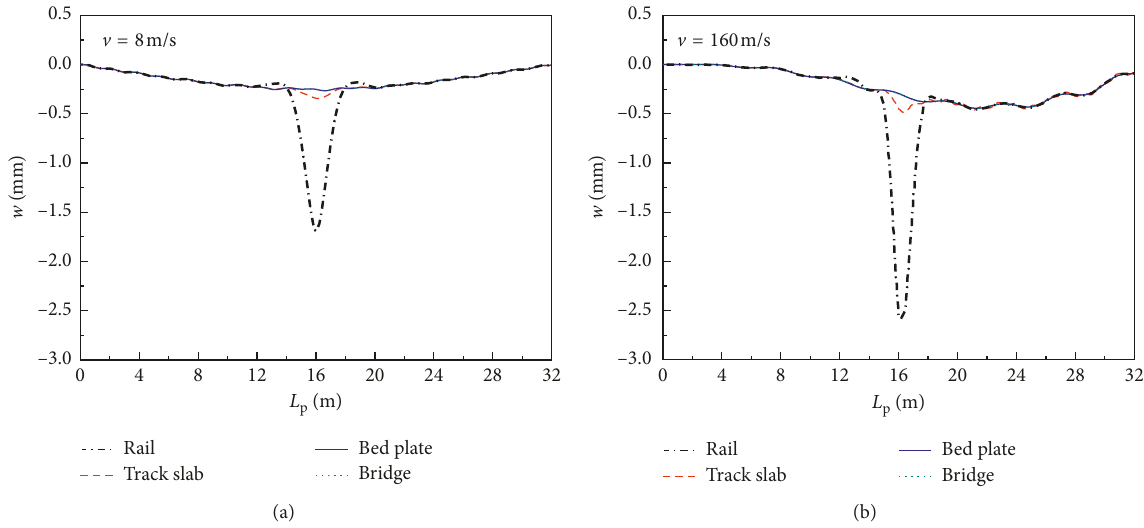
Figure 5: Comparison of dynamic deflection responses of rail, track plate, base plate, and bridge under different train Figure 7, the stiffness of the rubber pad under the supporting block mainly affects the vibrations of the rail and the track plate. When the stiffness of the rubber pad increases from